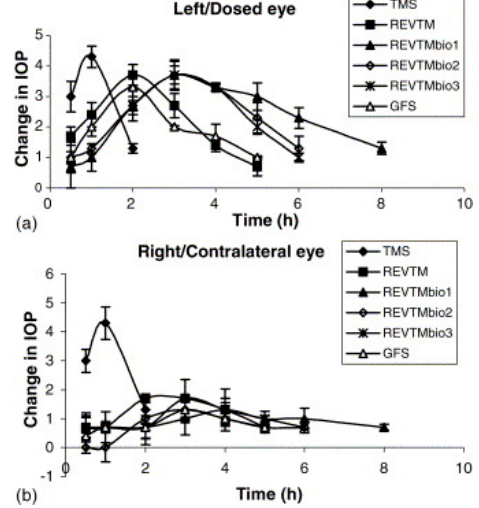
Figure 5. Change in intraocular pressure (IOP) for various formulations in ( a ) dosed eye ( b ) contralateral eye ( n = 6). (TMS—Timolol solution 0.25%, REVTM—Uncoated niosomes, REVTMbio1-chitosan coated niosomes, REVTMbio2 and 3-carbopol coated niosomes, GFS—Timolet ® GFS). Reprinted from [86]. Copyright (2018), with permission from